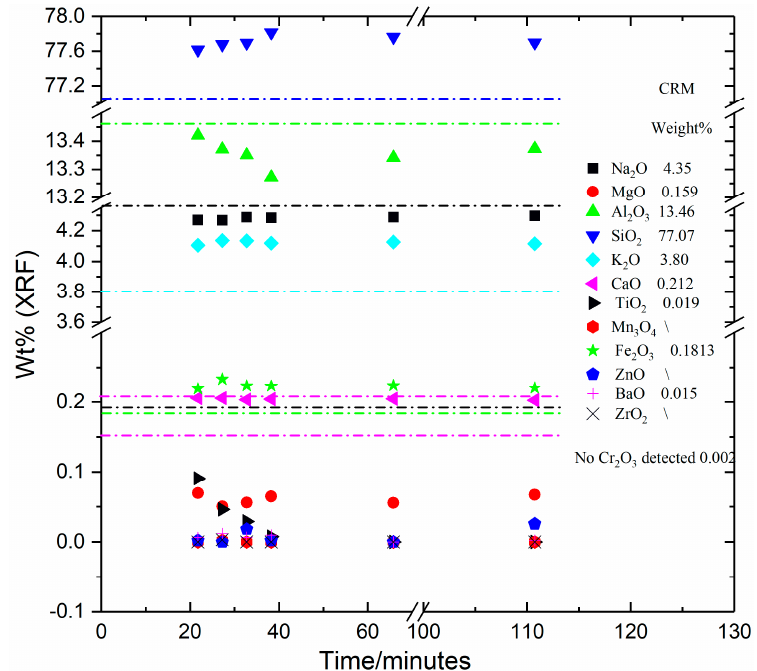
Figure 1. XRF OXI results for Certified Reference Material (CRM)-529 [41] (Anorthic Feldspar) as a function of total process time. Error bars are smaller than the data markers. Horizontal dotted lines indicate the certified composition of CRM-529. Analysed TiO 2 content includes contribution from I L β 1,2,3 lines.